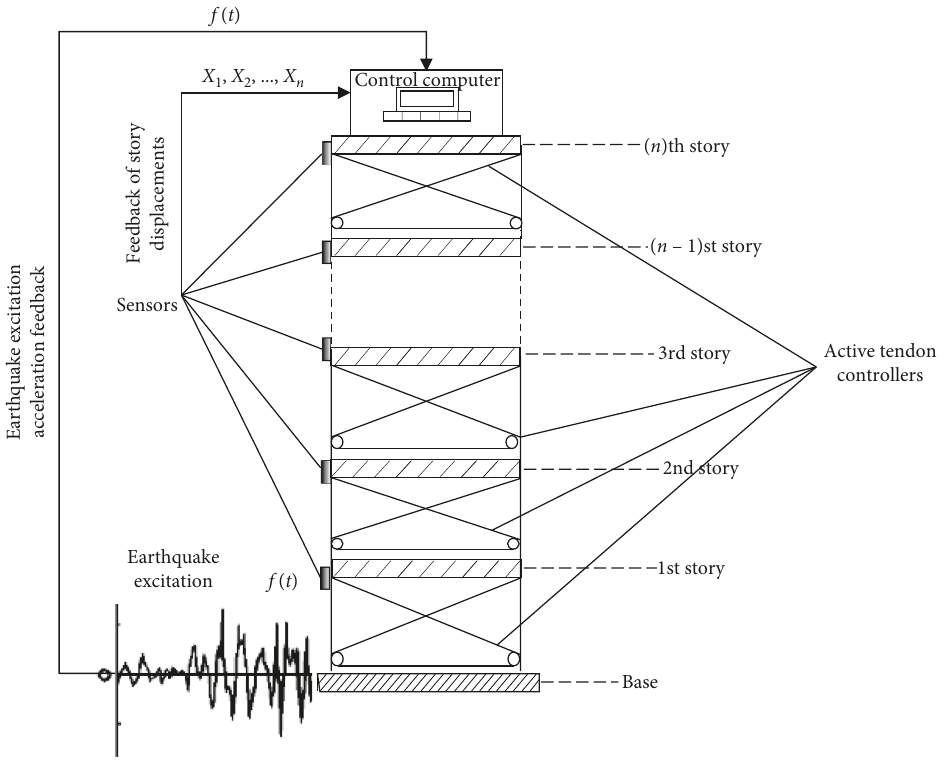
Figure 1: Example building with active tendon